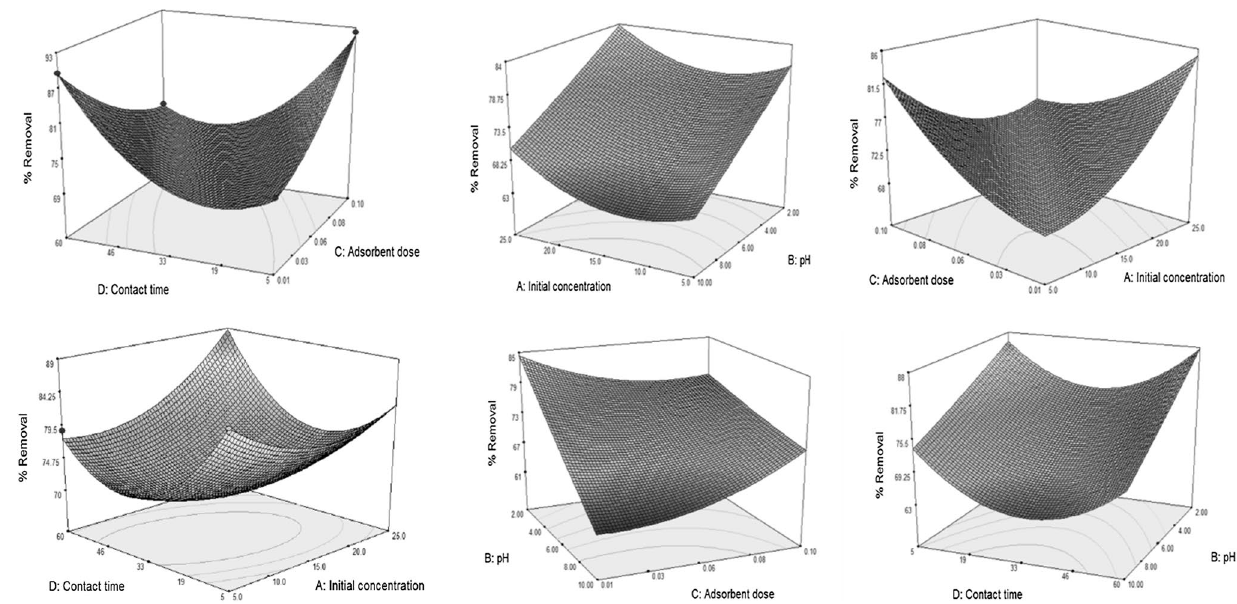
Fig. 4 Response surface 3D plots showing the effect of independent variables on carbaryl adsorption onto